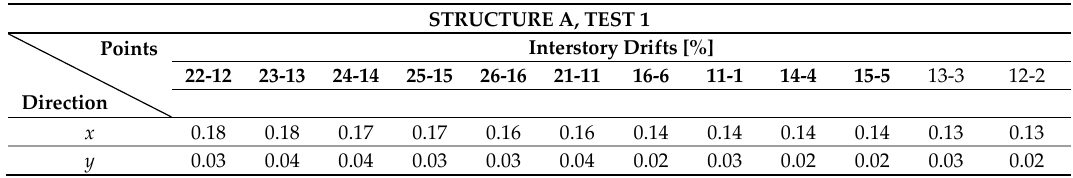
Table 11. Maximum interstory Drift [%], seismic action 2, combination (100% x , 30% y ).